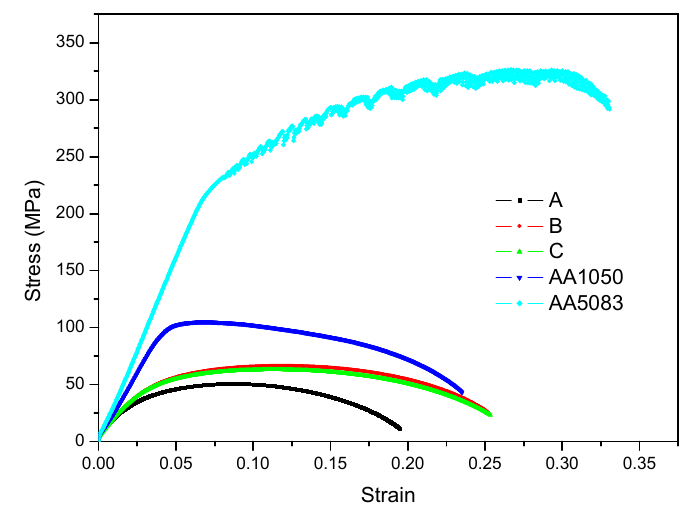
Figure 11. Stress-strain curve.